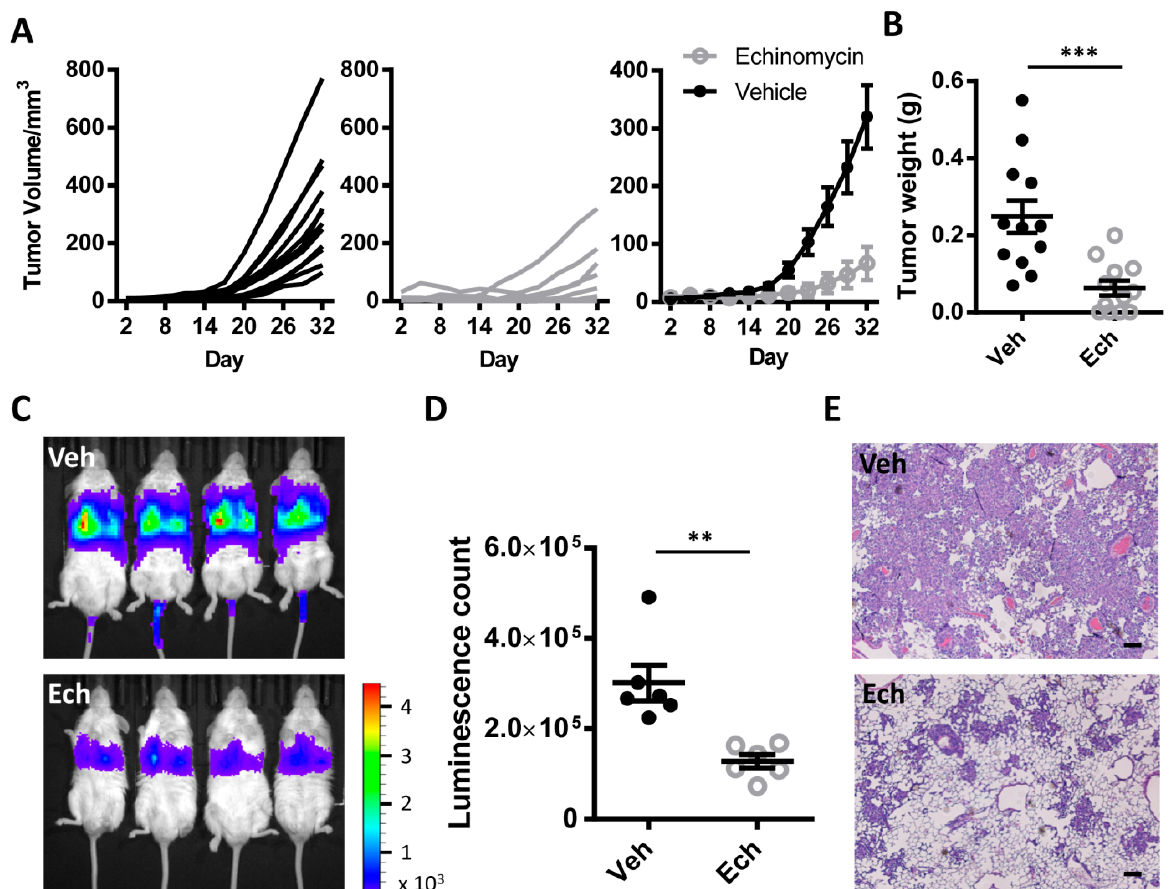
Figure 5. Targeting MYC and HIF1 α inhibited tumor growth in lung adenocarcinoma in xenograft mouse models. ( A ) Tumor growth of H1944 xenograft. H1944 cells (1 × 10 6 ) were injected s.c. into nude mice and treated with vehicle or echinomycin (200 μ g/kg) on day 6 and day 13 after cell transplantation. Tumor volumes were determined by caliper measurements. Left panel: tumor volume of vehicle treated mice; Middle panel: tumor volume of echinomycin treated mice; Right panel: average tumor volume of vehicle and echinomycin treated mice. n = 12 mice/group. ( B ) Tumor weight was measured on day 32 after cell transplantation in vehicle and echinomycin treated H1944 xenograft mice. n = 12 mice/group. ***, p = 0.003. ( C ) Representative images show the tumor cells in mice that received transplants of luciferase-expressing mouse Kras G12D/+ ; p53 − / − lung cancer cells in vehicle and echinomycin treated groups. ( D ) Quantification of bioluminescence count in ( C ). n = 6 mice/group. **, p = 0.002. ( E ) H & E staining shows the distribution of Kras G12D/+ ; p53 − / − cancer cells in vehicle and echinomycin treated mouse lung tissues. Scale bar: 200 μ m.